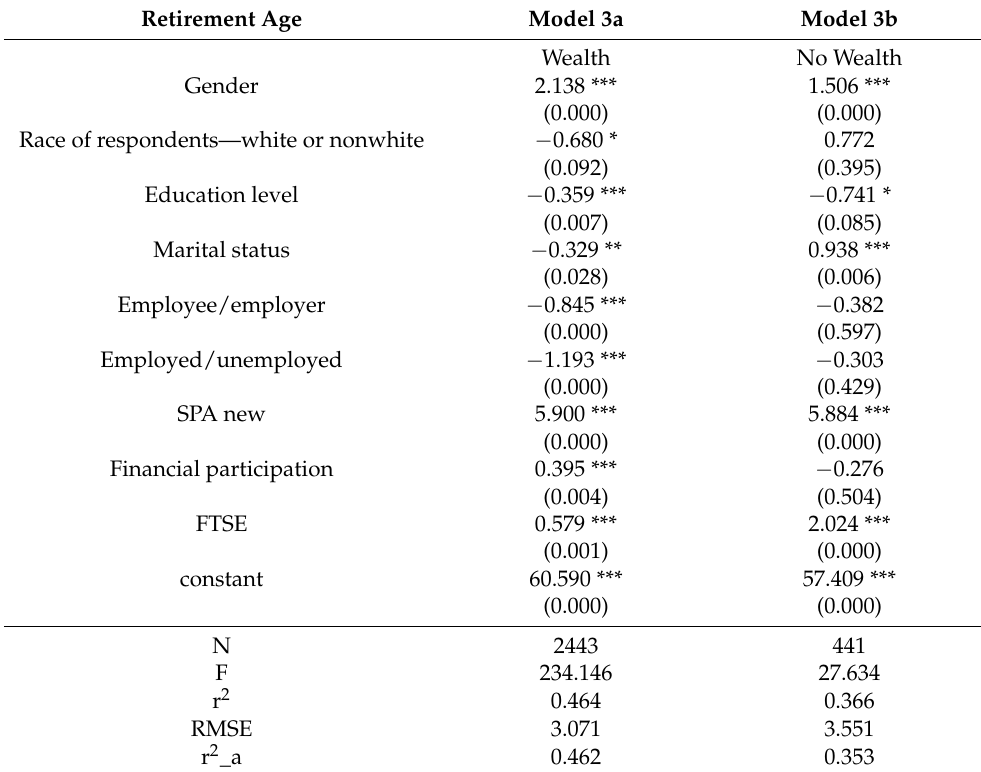
Table 3. Regression for the retirement age conditioned by